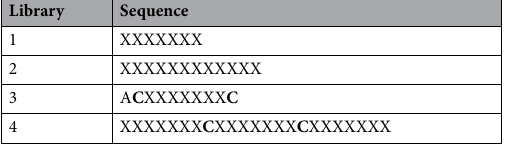
Table 1. Phage display libraries. The forms of phage display libraries used in biopanning. C = disulfide bridge. X = random. All sequences contained a C-terminal GGG linker as the fusion point of the displayed peptide and the N-terminus of the pIII M13 phage coat protein.